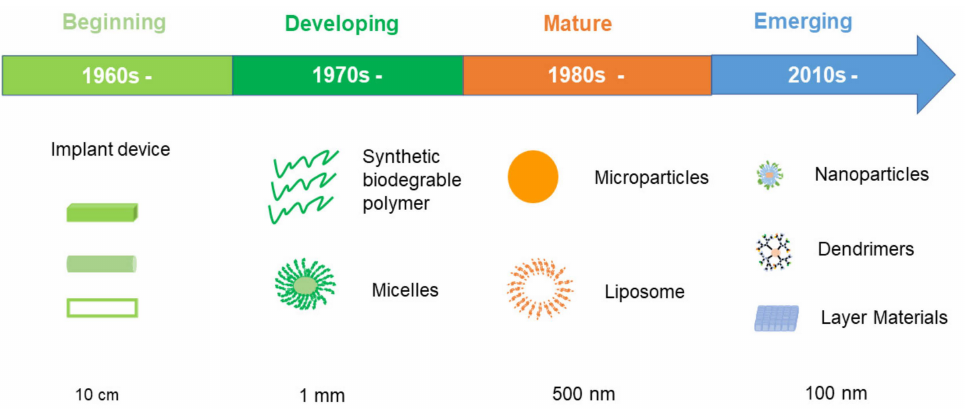
Figure 1. Schematic diagram summarizing the evolution of polymeric drug delivery systems (modi- fied from Kamaly et al., 2016